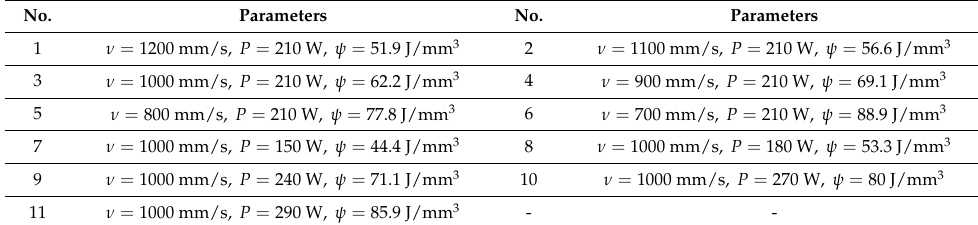
Table 3. Detailed process